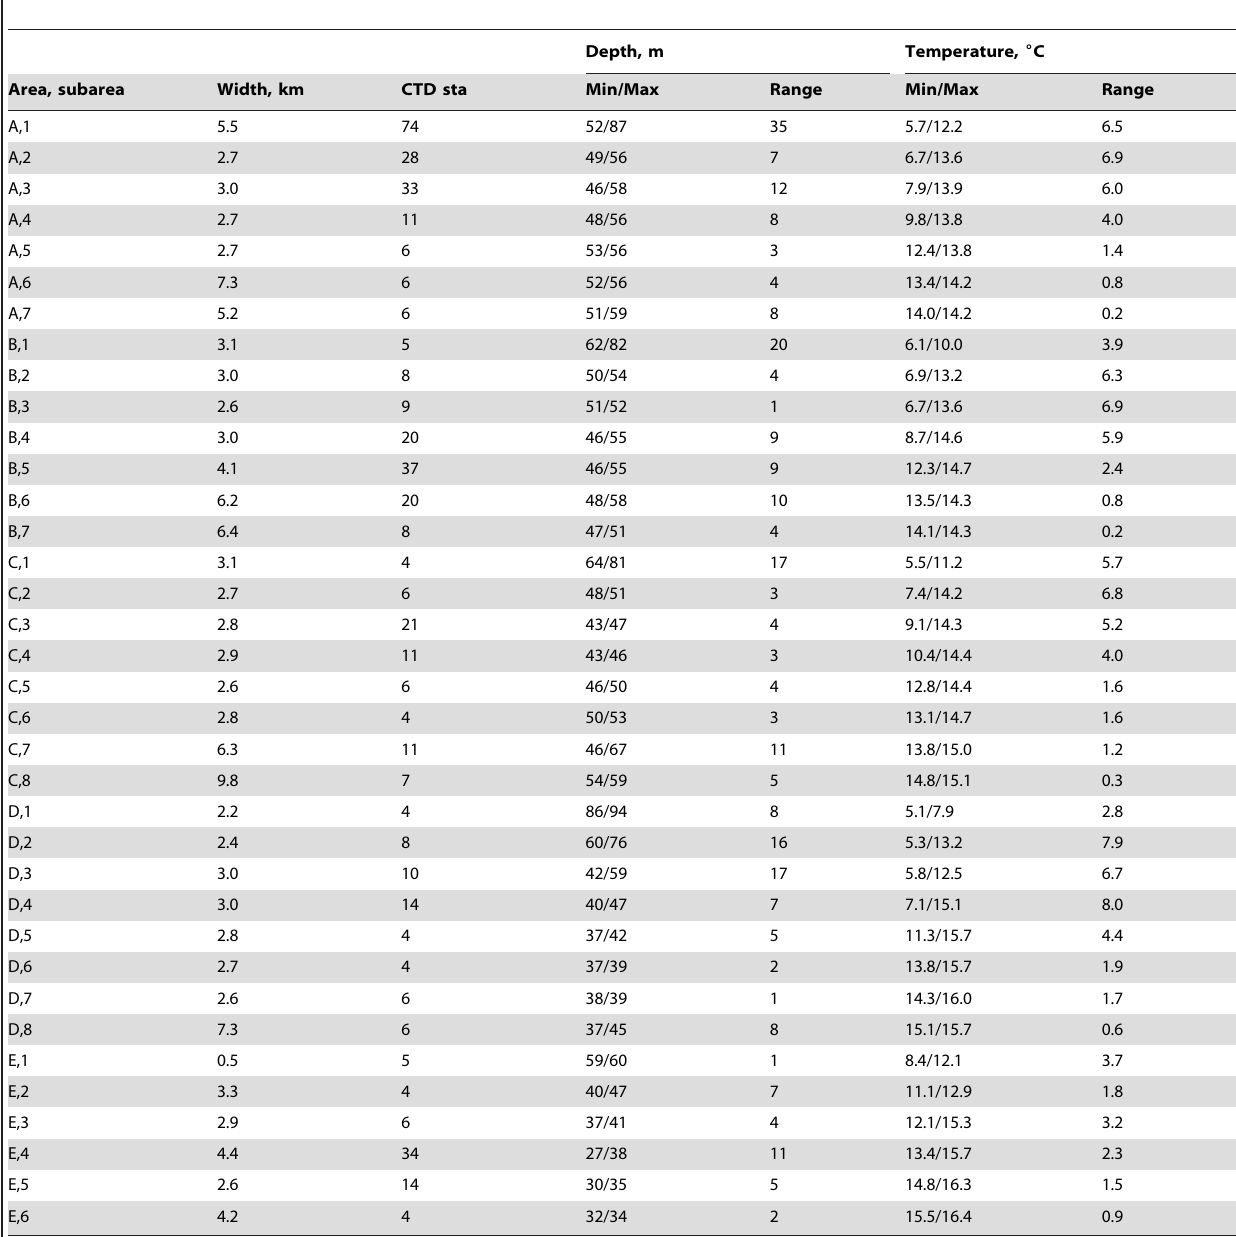
Table 5. Summary of seabed water depths and the frontal effect on temperature change in subareas of study areas